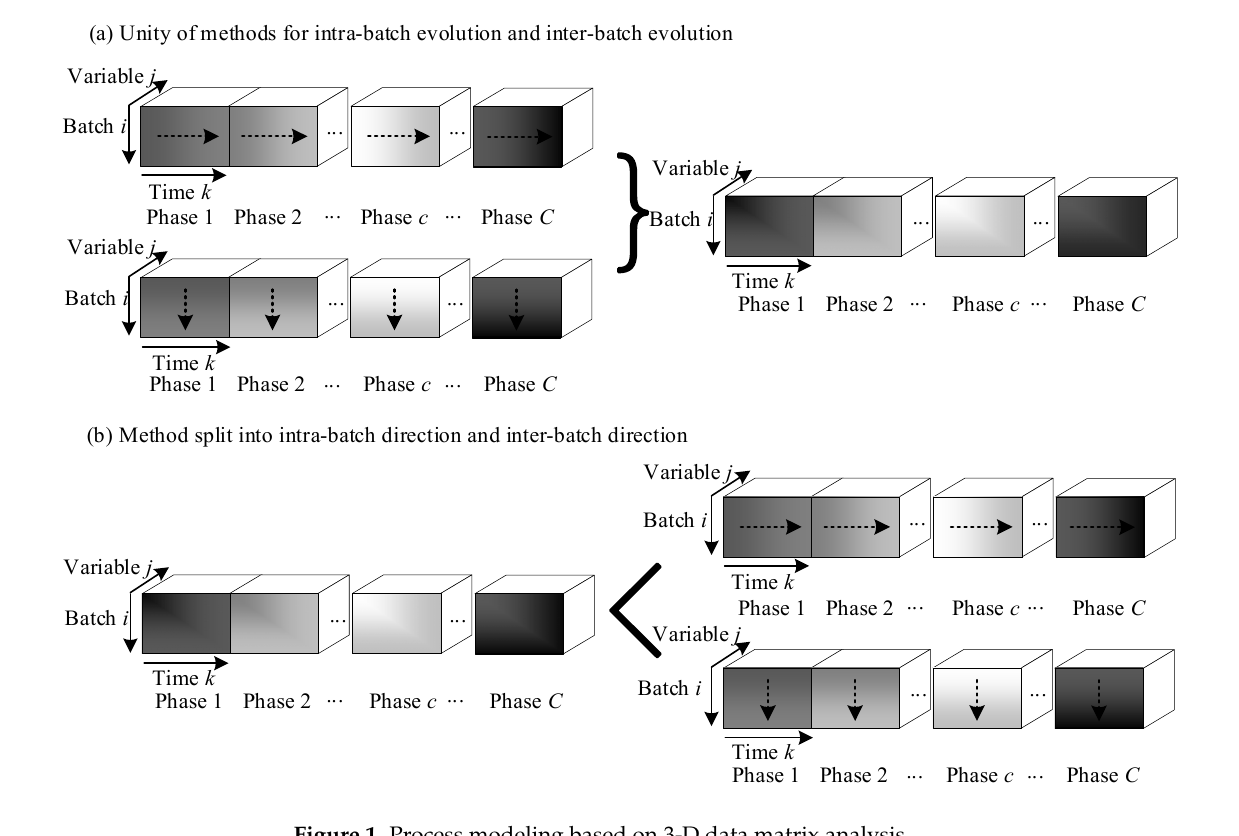
Figure 1. Process modeling based on 3-D data matrix analysis.